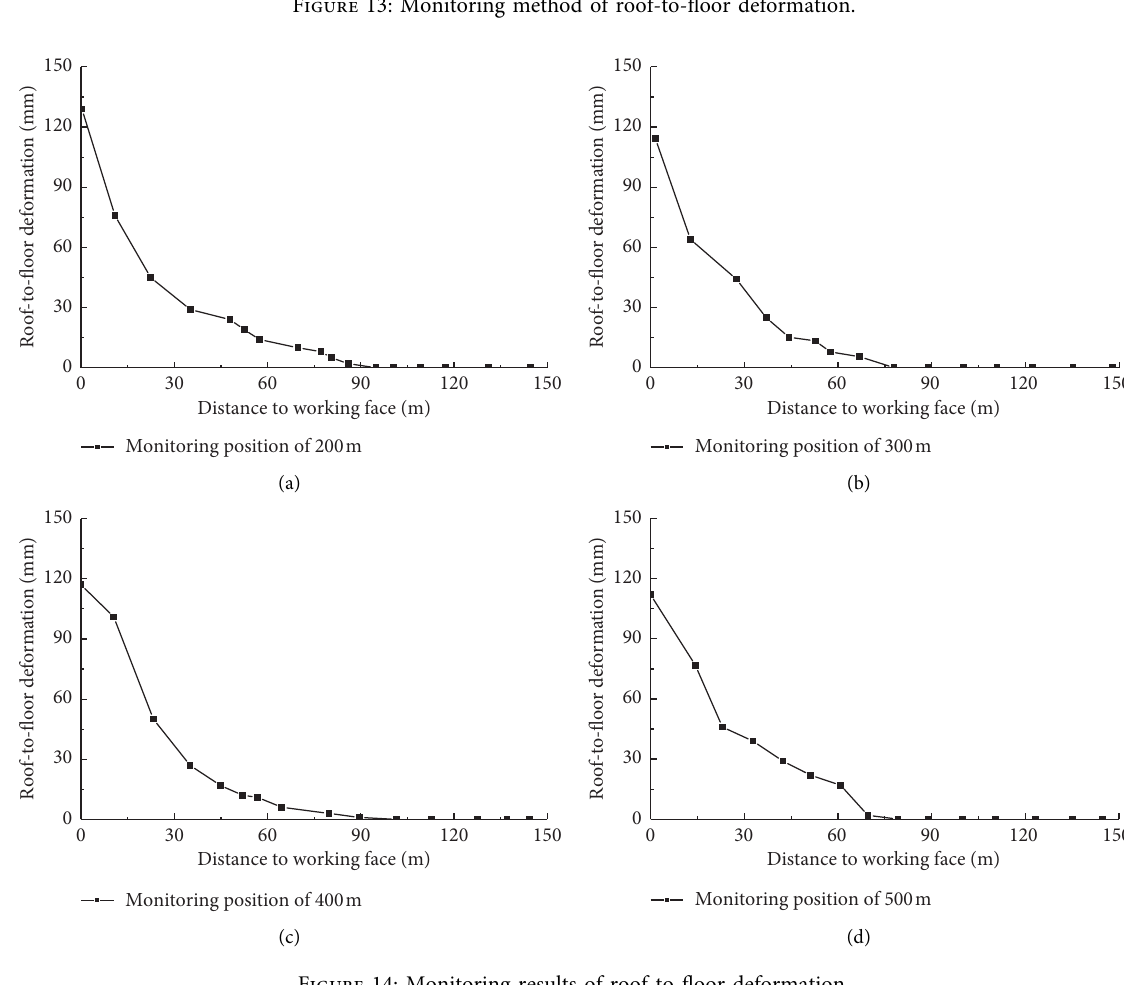
Figure 14: Monitoring results of roof-to-floor